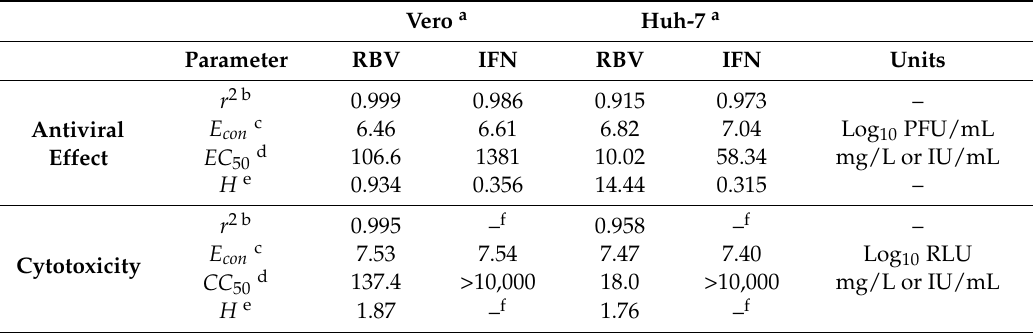
Table 2. Cytotoxicity and antiviral activity of Ribavirin (RBV) and Interferon- α (IFN) as single agents on Vero and Huh-7 cells. Vero